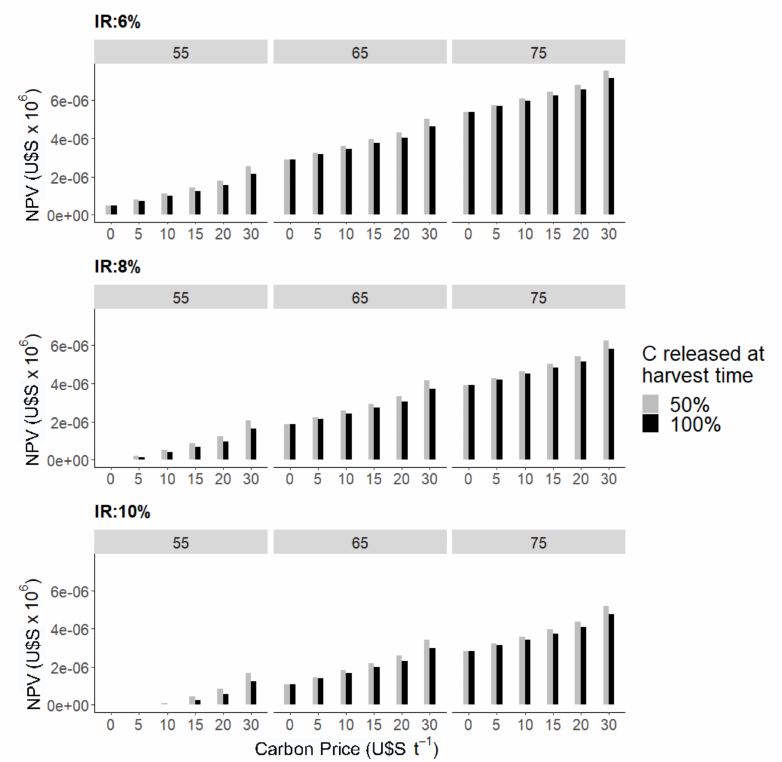
Figure 2. Net present value by C price (from 0 to 30 USD t − 1 ) for three interest rates (IR) and timber prices (55, 65, and 75 USD t − 1